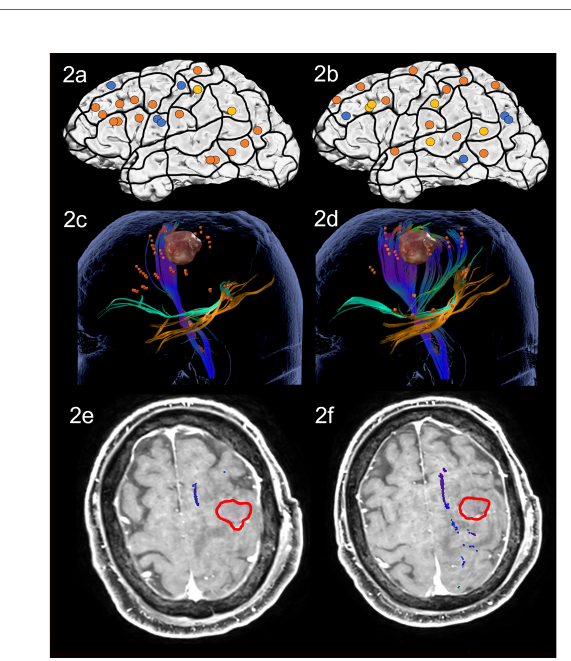
FIGURE 2 | Case 2. Left panels show ON results, right panels AN results. Panels (A, B) nTMS stimulation sites that induced errors; no response and hesitations in orange, semantic errors in yellow and performance errors in blue. Panels (C, D) Fiber tracking results including the lesion, nTMS cortical endpoints in orange and color-coded tracts with CNT in direction-coded, here dark blue, IFOF in turquoise, and ILF in yellow. Panels (E, F) Overlap of tracking and postoperative T1-weighted imaging after elastic fusion with the resection cavity marked in red.